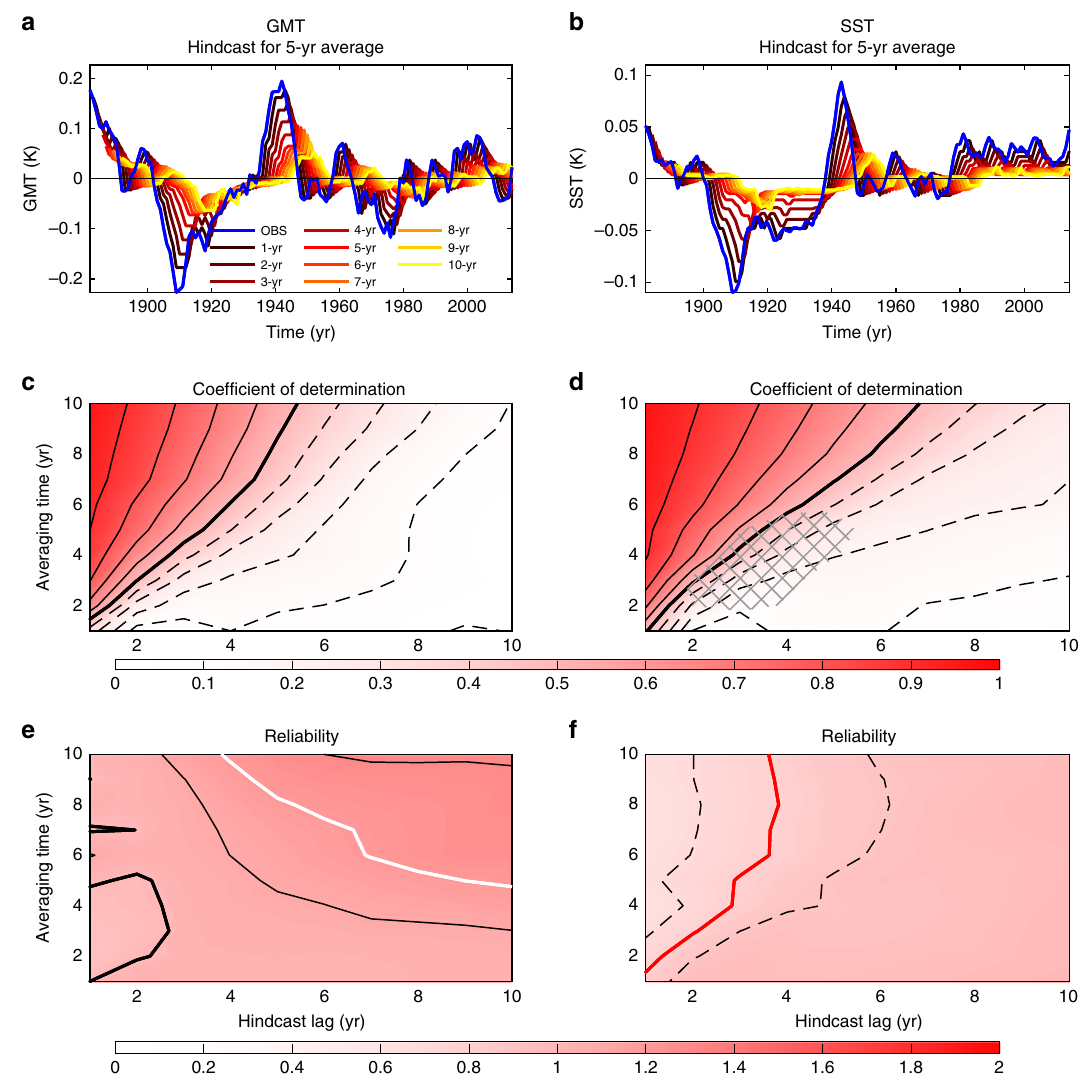
Fig. 5 Interannual hindcast skills of the observed GMT and SST. Example for 5-year average data of a , b GMT and SST observations (blue) with mean prediction for 1- to 10-year hindcast lags (from black to yellow lines, respectively). c , d Skill of the prediction measured by the coef fi cient of determination — R 2 — between observations and mean prediction for different hindcast lags and averaging times. The coef fi cient of determination between model observations and persistence (i.e., the null hypothesis of prediction) is also computed to give a benchmark. Thick contour lines represent values of 0.5, thin dashed — lower skill, and thin solid — higher skill, with contour intervals of 0.1; and hatching shows skill lower than the persistence. e , f Reliability of the prediction for different hindcast lags and averaging times. Thick red, black, and white contour lines represent values of 0.8, 1, and 1.2, respectively; thin black dashed and solid lines represent lower and higher values than 1, respectively, with contour intervals of 0.1. Note the better skill than persistence (almost no hatched region) and the good reliability close to 1 for all hindcast lags and averaging